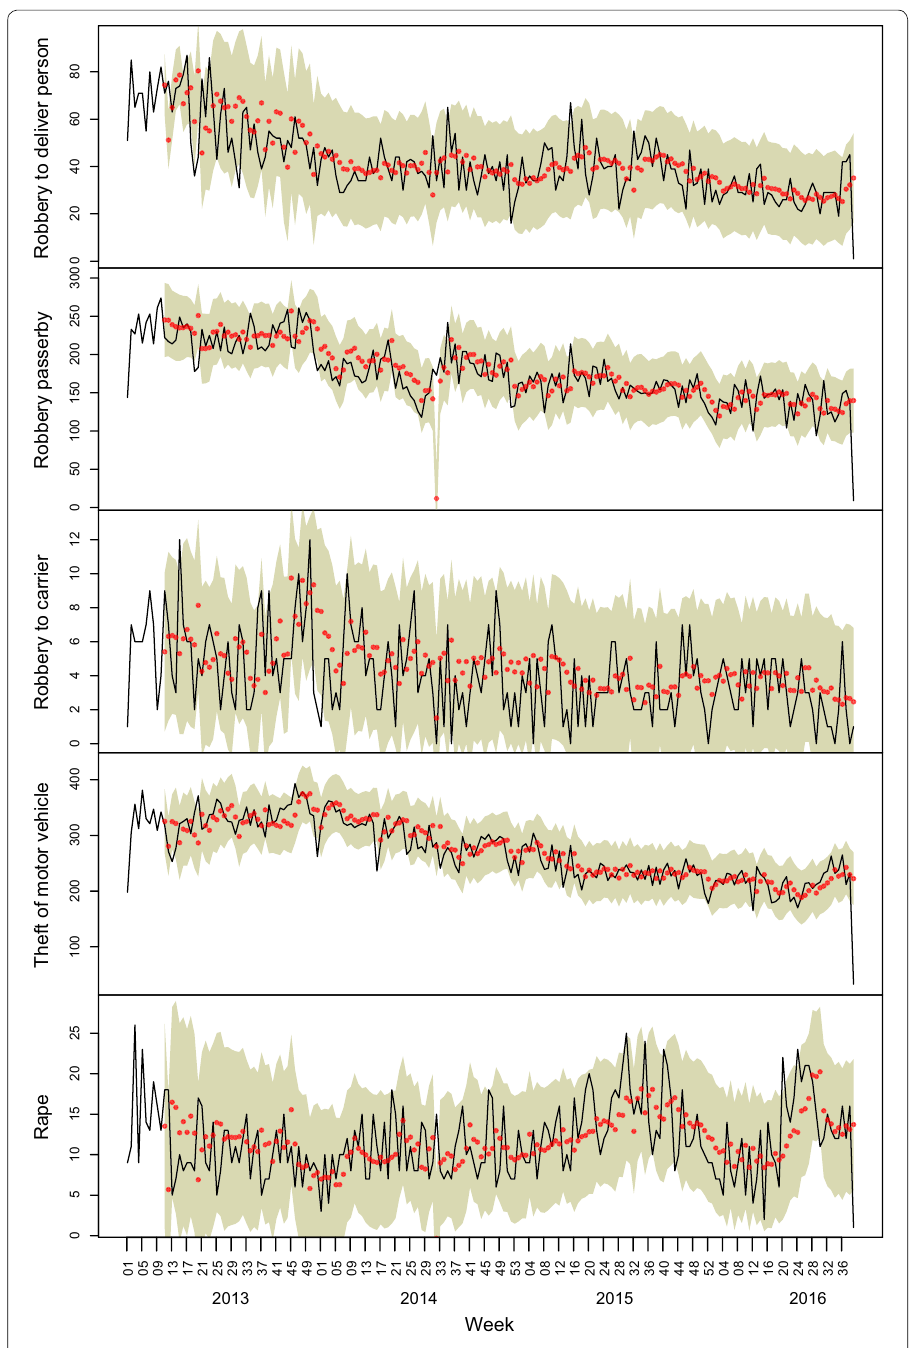
Fig. 17 One week adaptive forecasting for official crime dataset: part